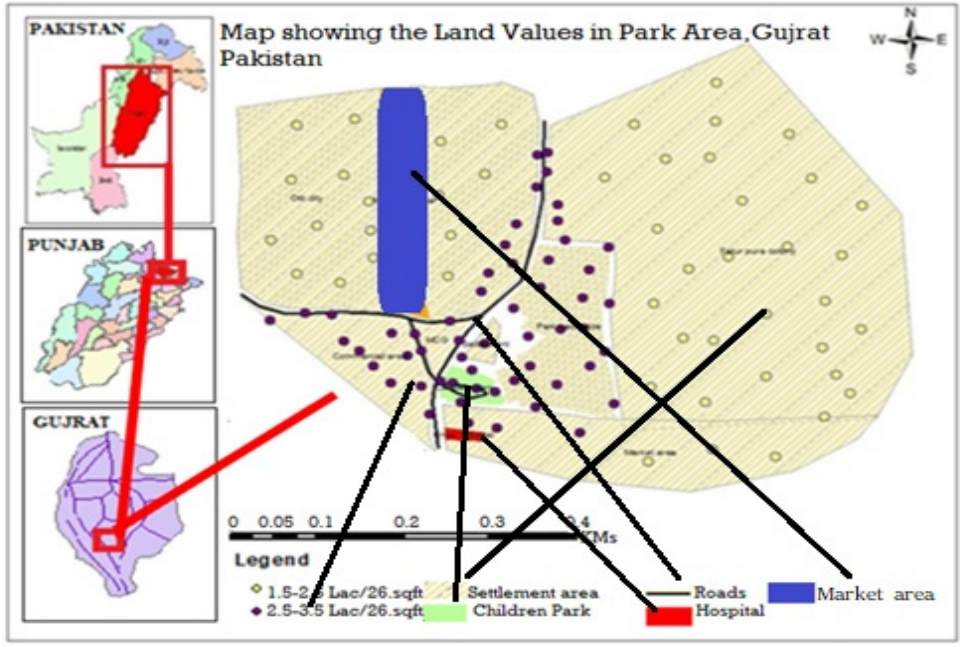
Figure 3. Map showing the land values and proximity.